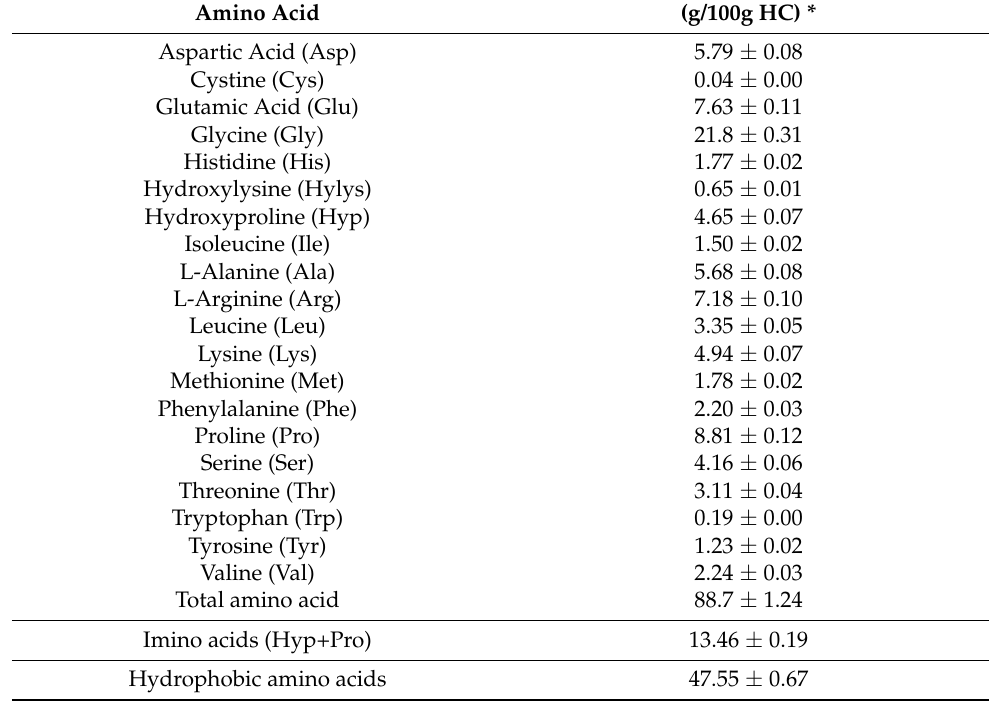
Table 1. Amino acid composition of defatted hydrolyzed collagen (HC) from salmon skin. Amino Acid (g/100g HC) * Aspartic Acid (Asp) 5.79 ± 0.08 Cystine (Cys) 0.04 ± 0.00 Glutamic Acid (Glu) Glycine